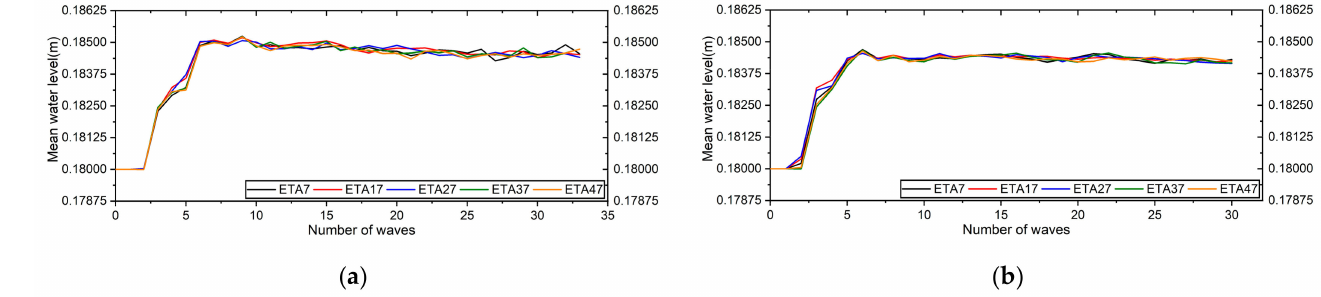
Figure 12. Variation in mean water levels per wave for cross-sections 1–5 at radial distances of 426 cm in ( a ) case 1 (T-1.80 s), and ( b ) case 2 (T-2.0